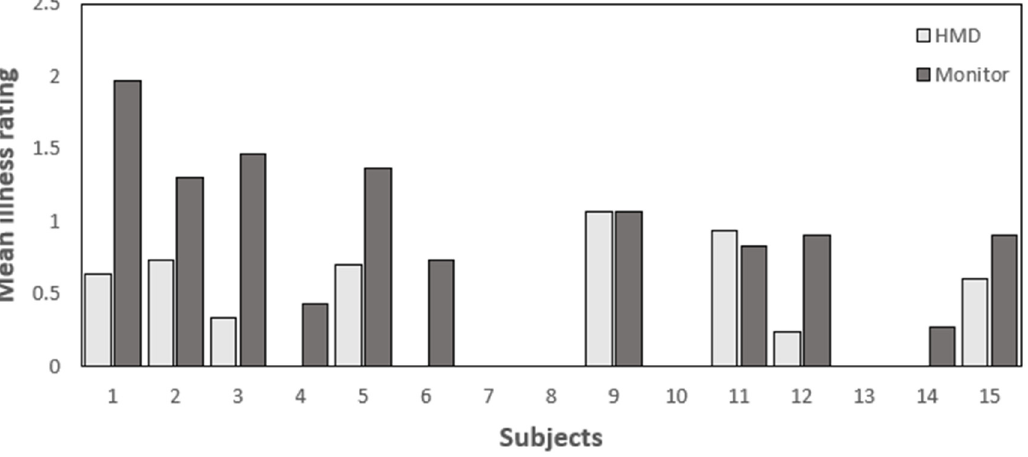
Figure 3. Mean illness ratings for each subject during 30 min exposure to roll oscillation in the two visual conditions.